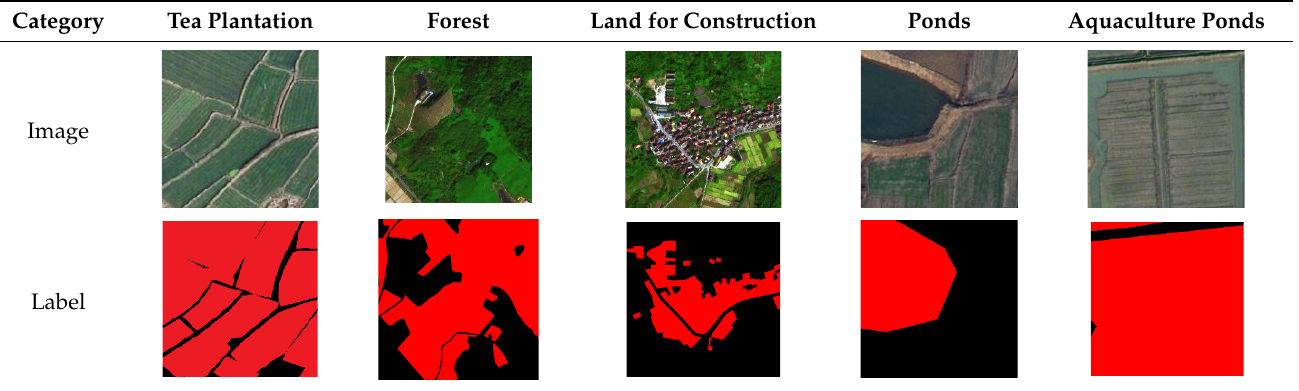
Figure 4. Cultivated land in the third land surveys. ( a1 – a3 ) Paddy fields samples; ( b1 – b3 ) Dry land samples; ( c1 – c3 ) Irrigated land samples.